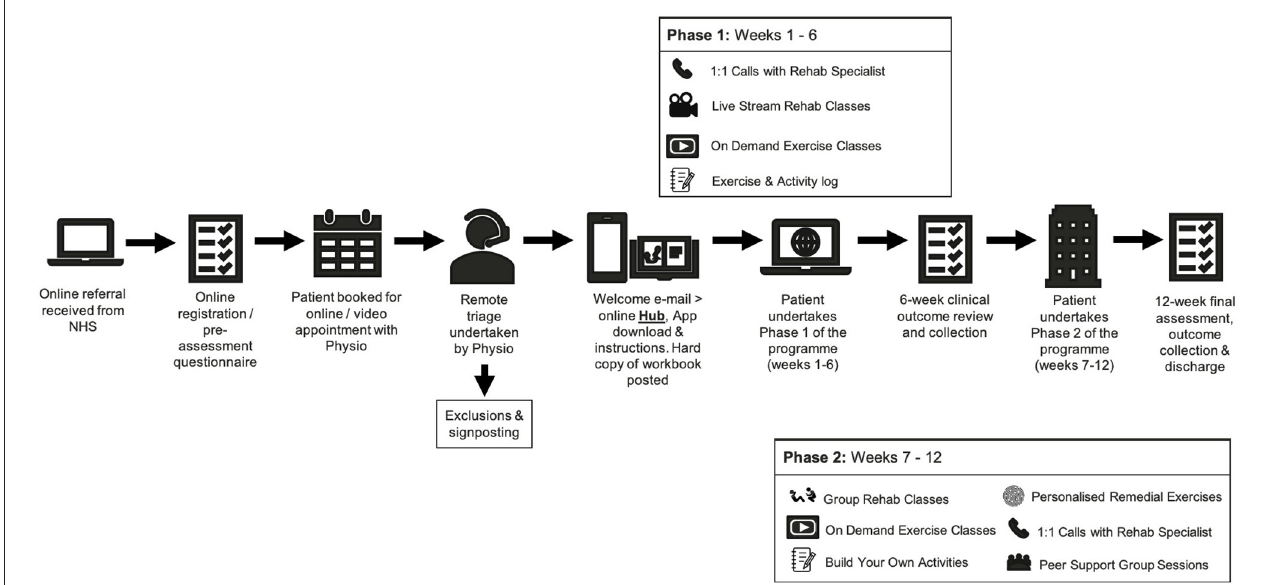
FIGURE 1 | Pathway illustration of the 12-week community rehabilitation programme.